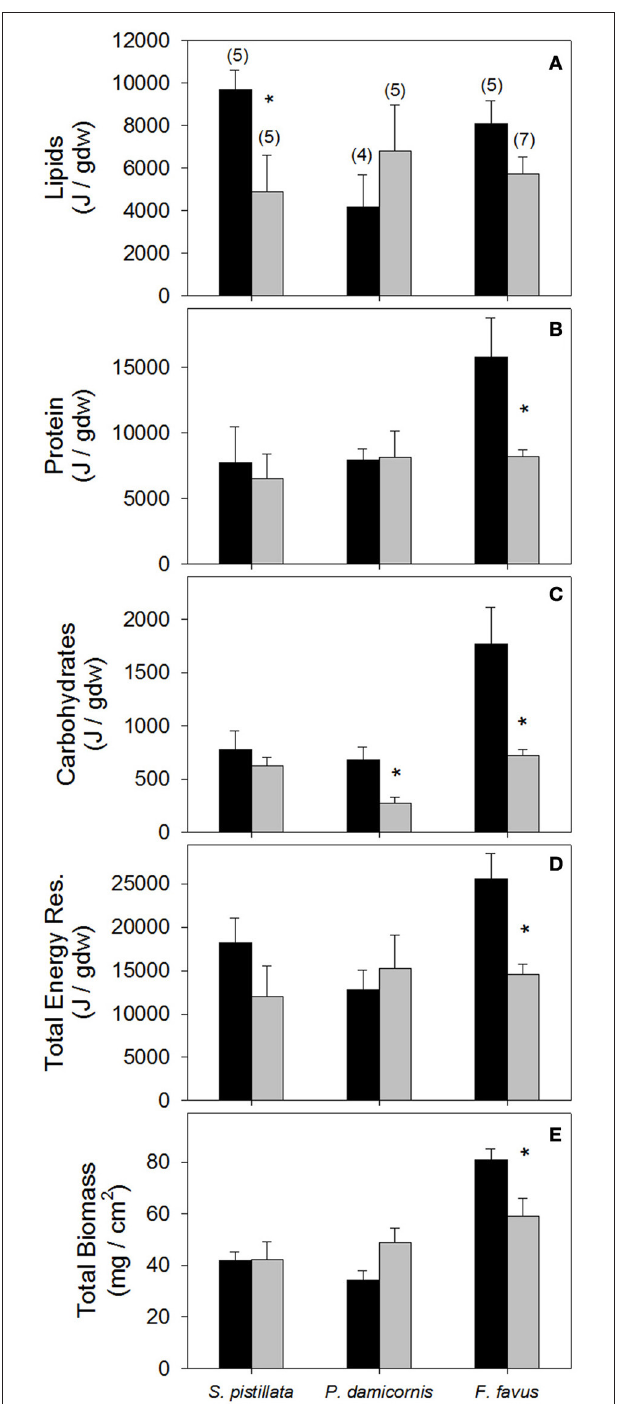
FIGURE 2 | Average (A) Lipid, (B) protein, (C) carbohydrate, (D) total energy reserves, and (E) total biomass in control (black bars) and bleached (gray bars) Stylophora pistillata , Pocillopora damicornis , and Favia favus corals. Averages are plotted ± 1 standard error, sample sizes for all panels indicated in brackets in (A) , and significant differences between average control and bleached values within each species are indicated with a *. Corresponding